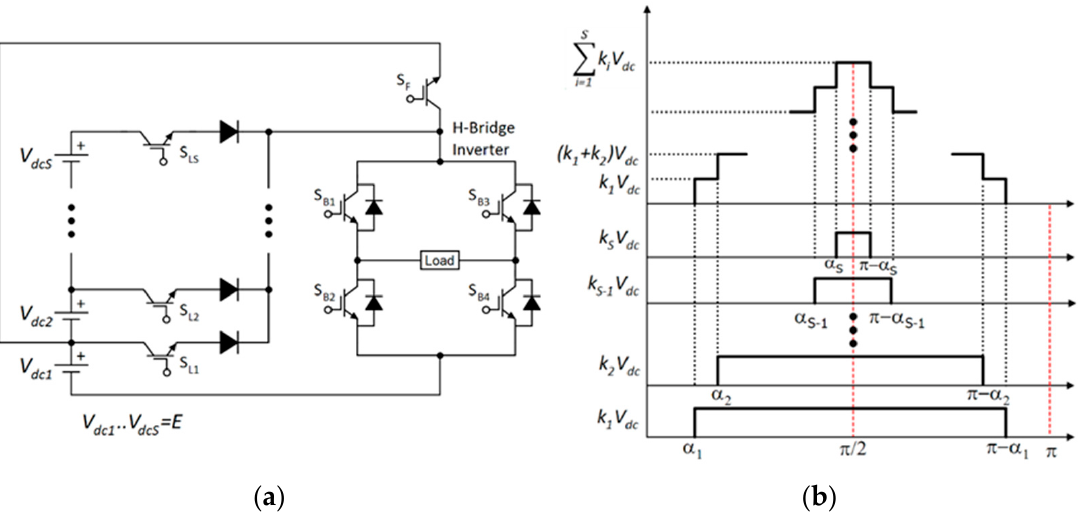
Figure 1. ( a ) MLI structure; ( b ) ladder waveform of seven − level inverter.